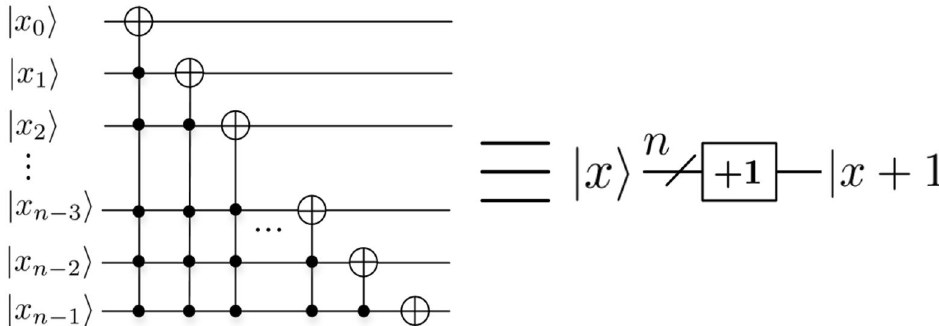
Figure 5. Adding one module 32 .